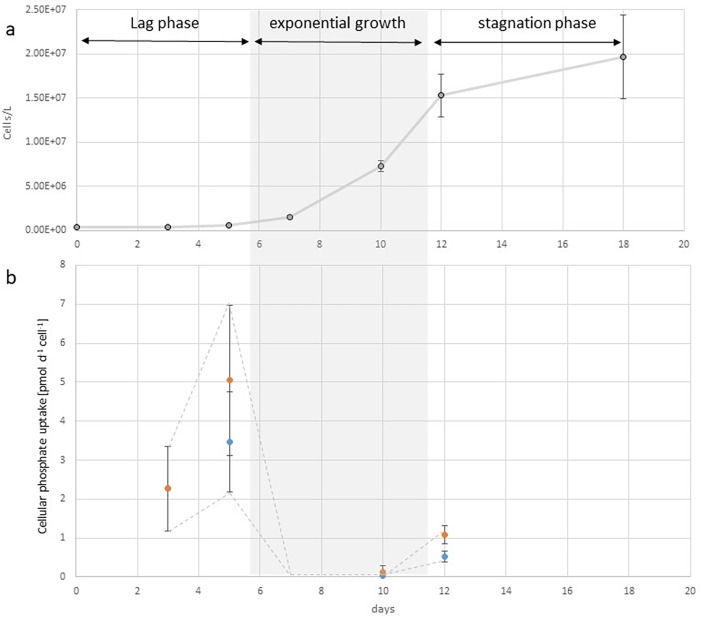
Dynamics of phosphate uptake rates throughout batch cultures of C. peruvianus in F/2 medium.(a) Average cell concentrations (and standard deviations) plotted over the duration of the batch culture.in days. The phases of the growth curve are indicated. (b) Cellular phosphate uptake rates calculated as phosphate uptake divided by cell numbers at the days of phosphate quantification (blue, or lower values) and divided by the cell numbers at the day of the measurement before (orange, or higher values). The dashed line indicates lower and upper borders between the two calculation methods. The true uptake rate must be between the two borders. Note the steep drop of phosphate uptake rates during exponential growth.